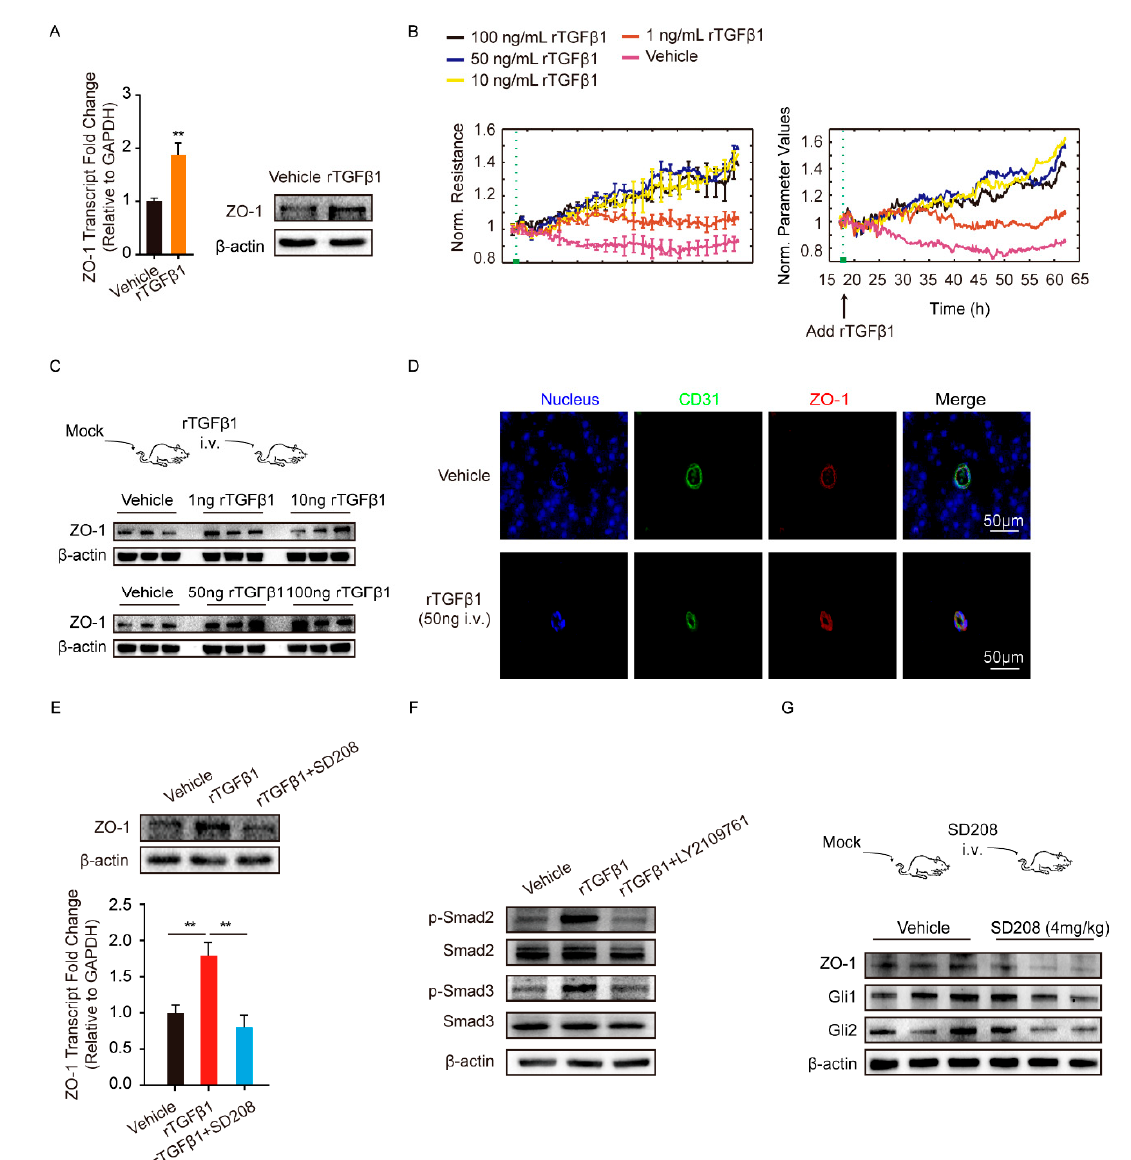
Figure 2. TGF β 1 treatment enhanced BMECs tight junction protein ZO-1 expression. ( A ) The rTGF β 1 treatment (50 ng/mL) on the expression of ZO-1 in monolayer hBMECs. ** p < 0.01. ( B ) The effect of rTGF β 1 treatment on hBMECs barrier resistance monitored via ECIS system. The assay was performed with 5 replicates. ( C ) The effect of rTGF β 1 injection on the ZO-1 expression in mouse brains ( n = 3). The β -actin was used as the loading control for the blotting. ( D ) IF demonstrated the ZO-1 expression on BMECs of the mice in response to rTGF β 1 treatment (50 ng, i.v.). BMECs were marked with CD31 in green. Scale bars indicated 50 µ m. ( E ) The effects of rTGF β 1 treatment (50 ng/mL) and TGF β 1 signaling on the expression of ZO-1 in hBMECs. The qPCR assays were performed in triplicate, and data are represented as mean ± SEM. ** p < 0.01. ( F ) The phosphorylation activation of Smad2 and Smad3 in hBMECs by the treatment of rTGF β 1 (50 ng/mL). ( G ) The effects of SD208 injection (4 mg/kg i.v.) on the expression of ZO-1, Gli1 and Gli2 in mouse brains ( n = 3). The β -actin was tested as the loading control. Results of 3 mice in each group were randomly presented.